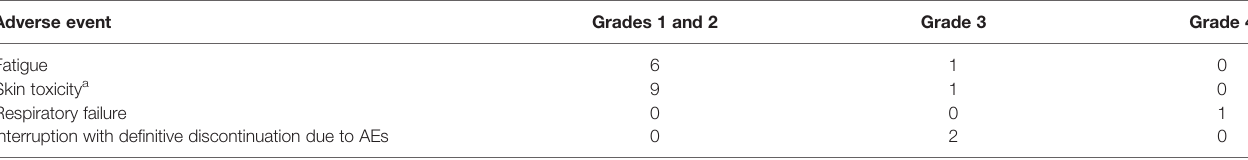
TABLE 3 | Treatment-related adverse events